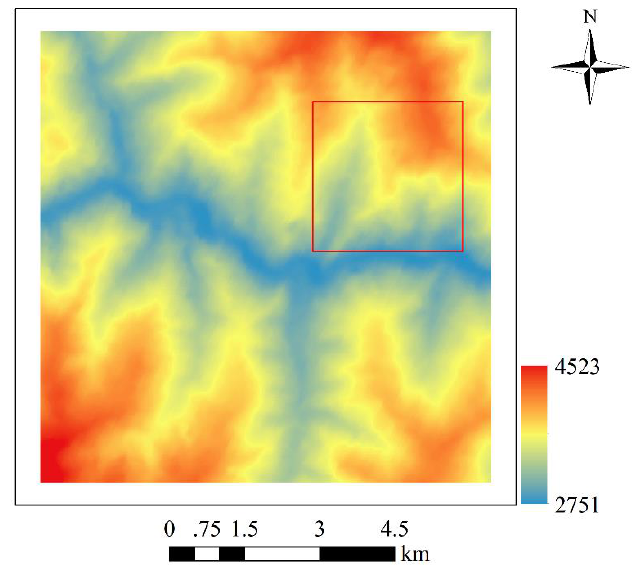
Figure 7. Test digital elevation model (DEM) used in this study. The red box delineates a subregion (number of the grid cells of 100 × 100) to support a visual comparison.